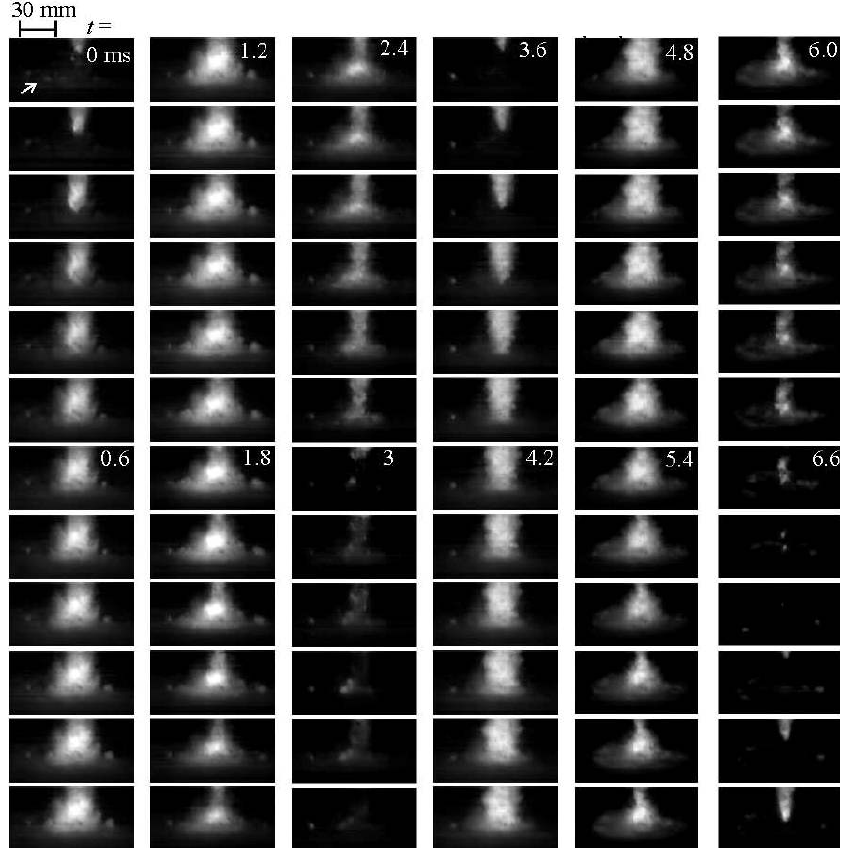
Fig. 5 The changing phase of the impinging jet